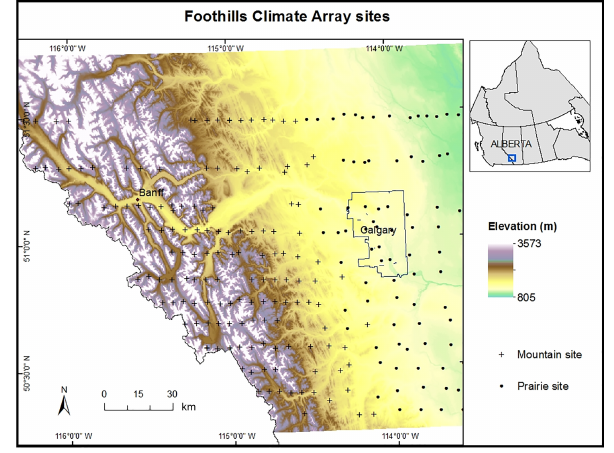
Figure 1. Foothills Climate Array study area. Crosses indicate mountain sites and dots are prairie sites. The City of Calgary munic- ipal boundary is shown as a black outline. Sites within the boundary are classified as urban